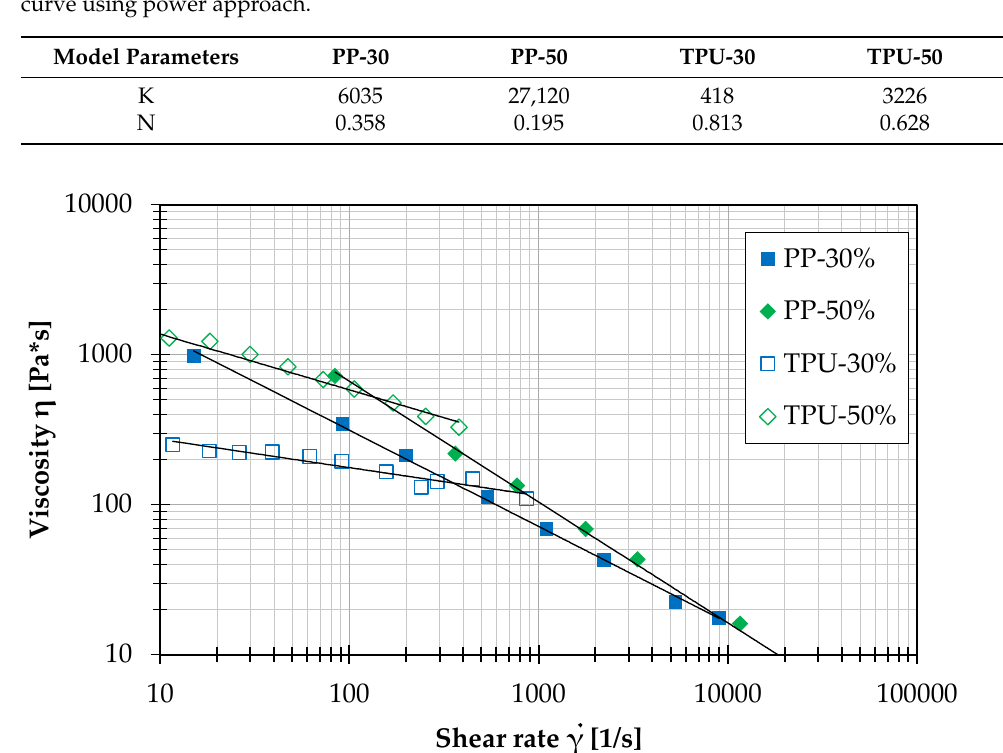
Figure 2. Viscosity as a function of shear rate at 190 °C for 30 wt.% / 50 wt.% PP and 30 wt.% / 50 wt.% TPU.